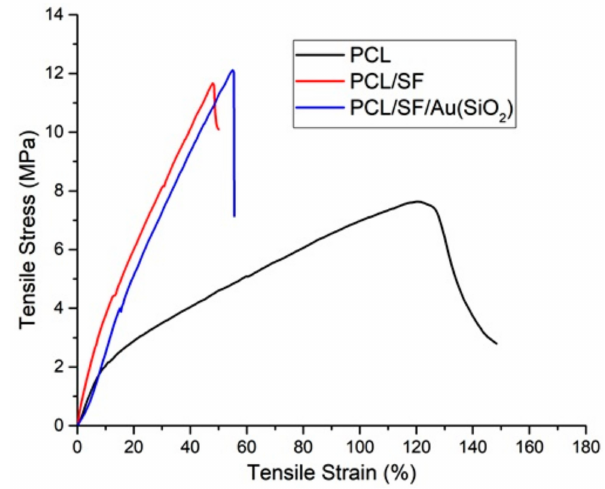
Figure 4. Tensile stress–strain curves of PCL, PCL / SF, PCL / SF / Au(SiO 2 ) nanofibrous sca ff